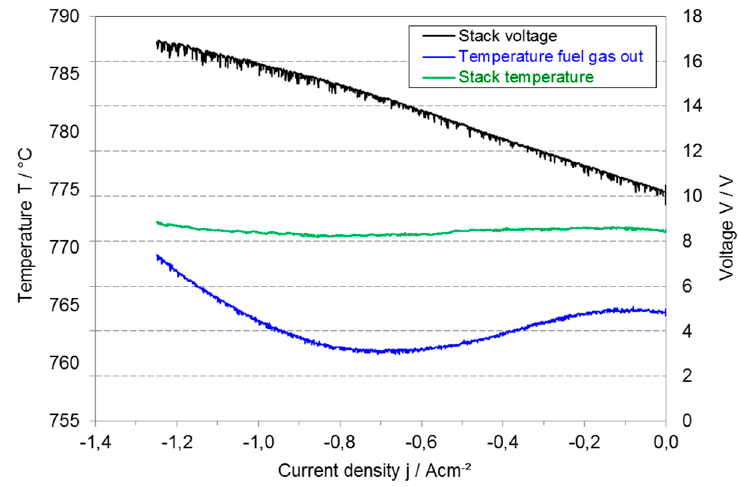
Figure 8. Current-voltage characteristics of the electrolyser stack operated at 770 °C and 12.0 slpm steam flow rate according to [6].